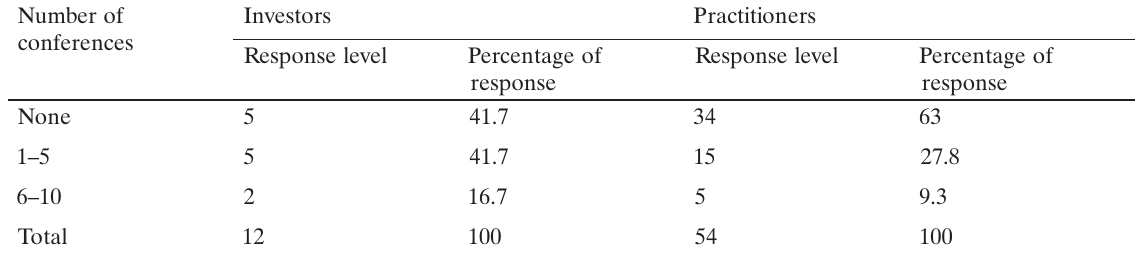
Table 5. Number of conferences, workshops or seminars attended by investors and practitioners